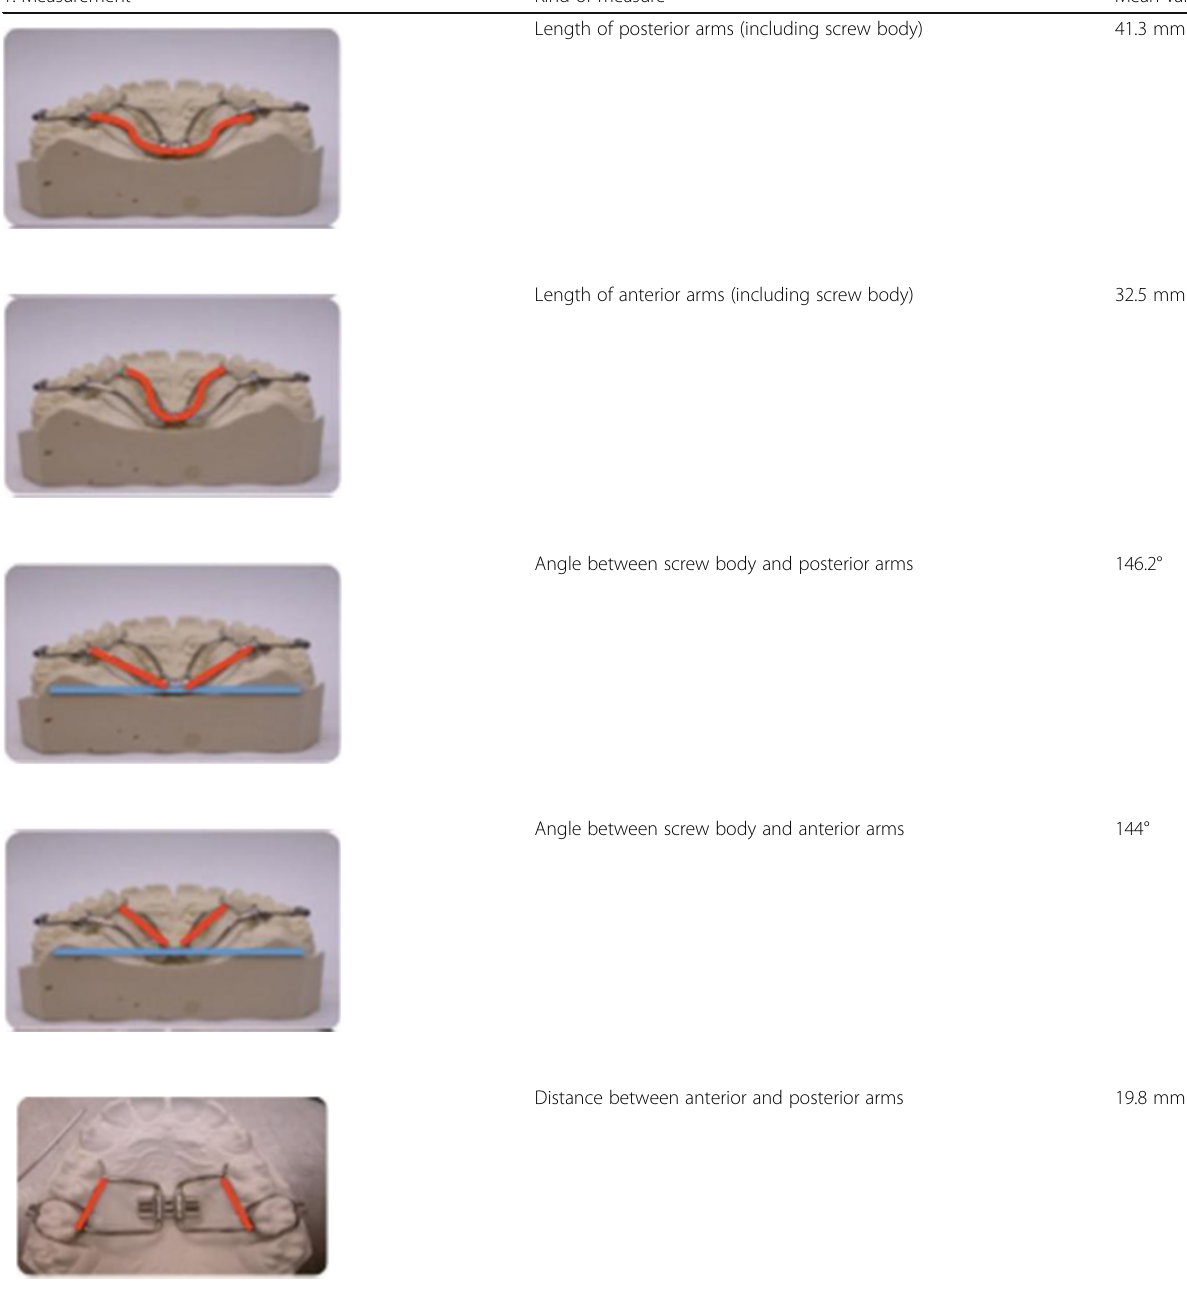
Table 2 Means of measures 1.